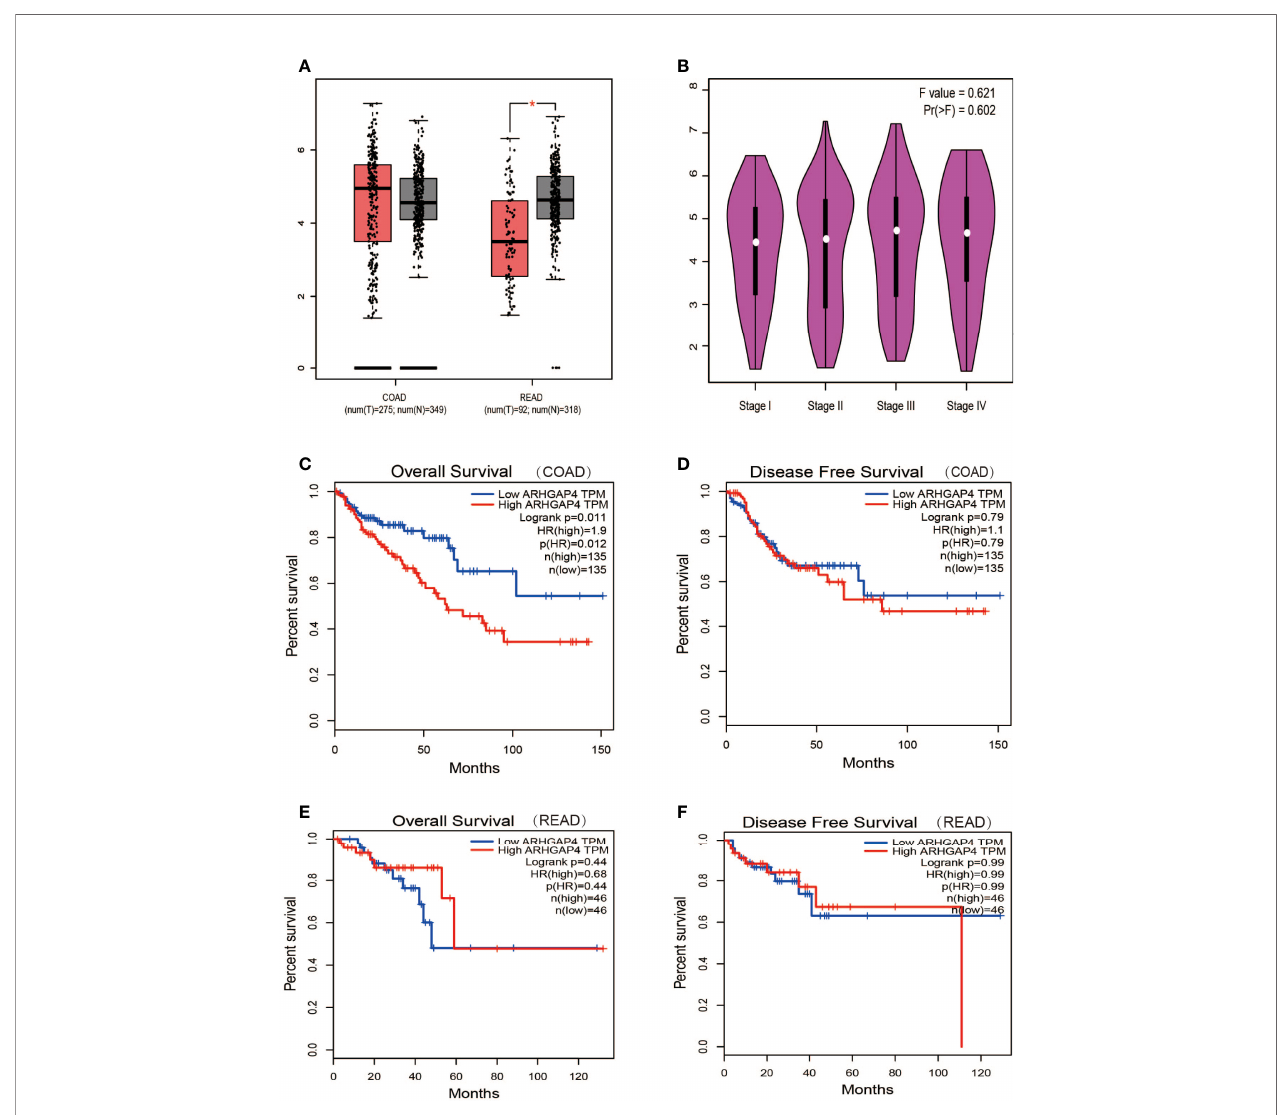
FIGURE 3 | Expression and prognosis of ARHGAP4 in CRC. (A) ARHGAP4 is expressed in colorectal adenocarcinoma (COAD) and READ (rectal adenocarcinoma). (B) ARHGAP4 is expressed in each clinical stage. (C, D) The relationship between ARHGAP4 expression and OS and DFS in COAD. (E, F) The relationship between ARHGAP4 expression and overall survival (OS) and disease-free survival (DFS) in READ. *Indicates that the P value is less than